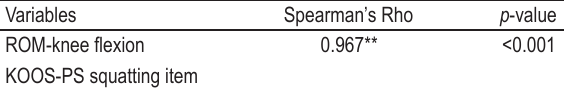
TABLE 4. Spearman correlation coefficient (Spearman’s Rho) of